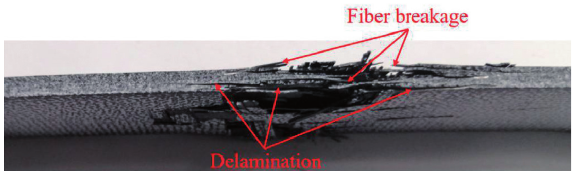
Figure 11: Fracture morphology of a representative scratched